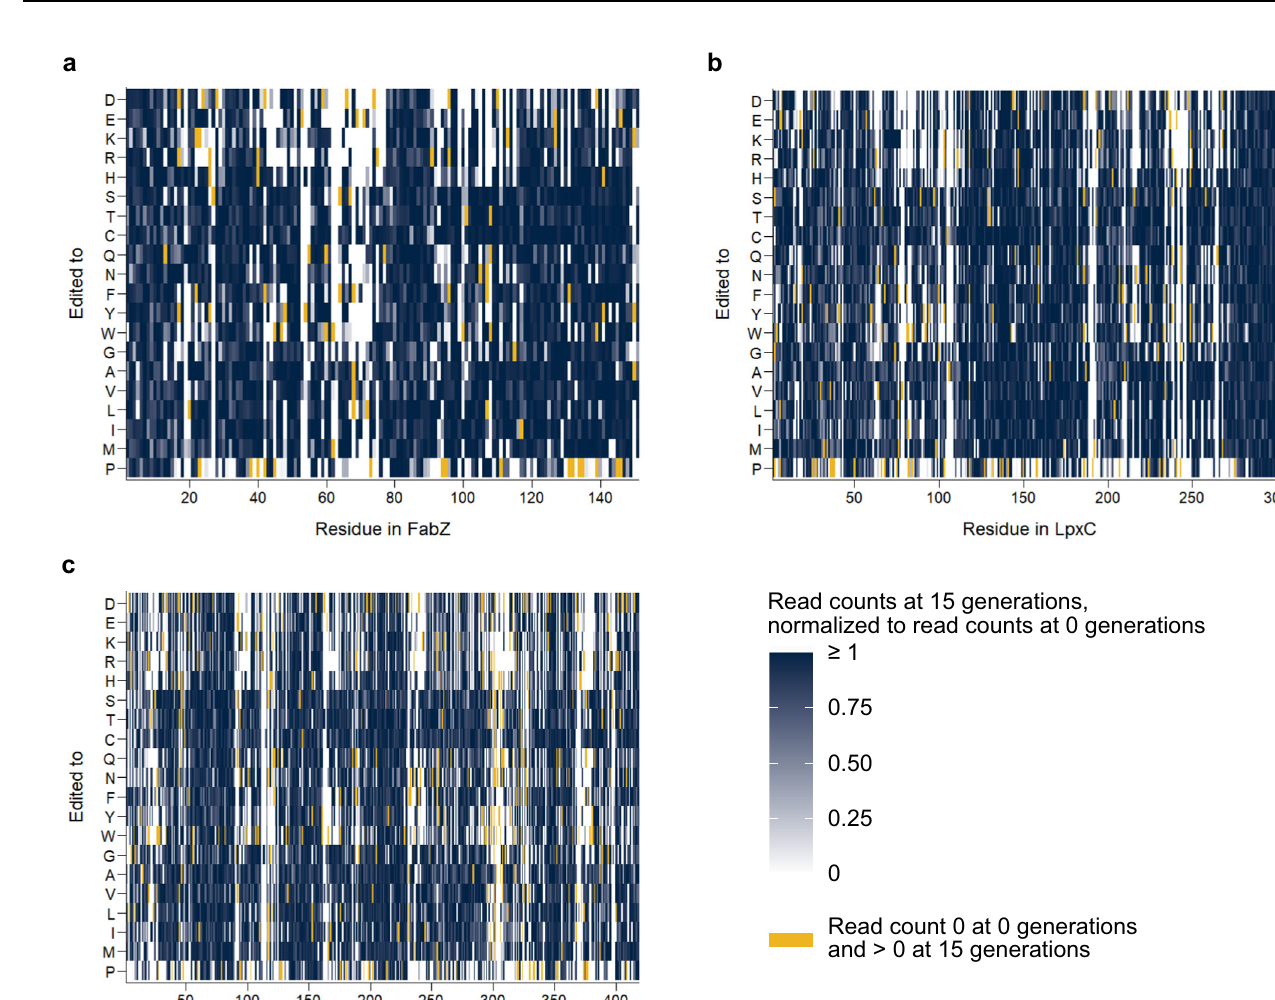
growthwerenormalizedtothereadcountsofthesameeditatthestartofselection (0 generations). The average of these normalized read counts of all three repeats wastakenasinputfortheseheatmaps.Thoseeditsthathadareadcountofzeroat the start of selection, but a non-zero read count after 15 generations of growth are shown in yellow. Source data are provided as Supplementary Data 3.